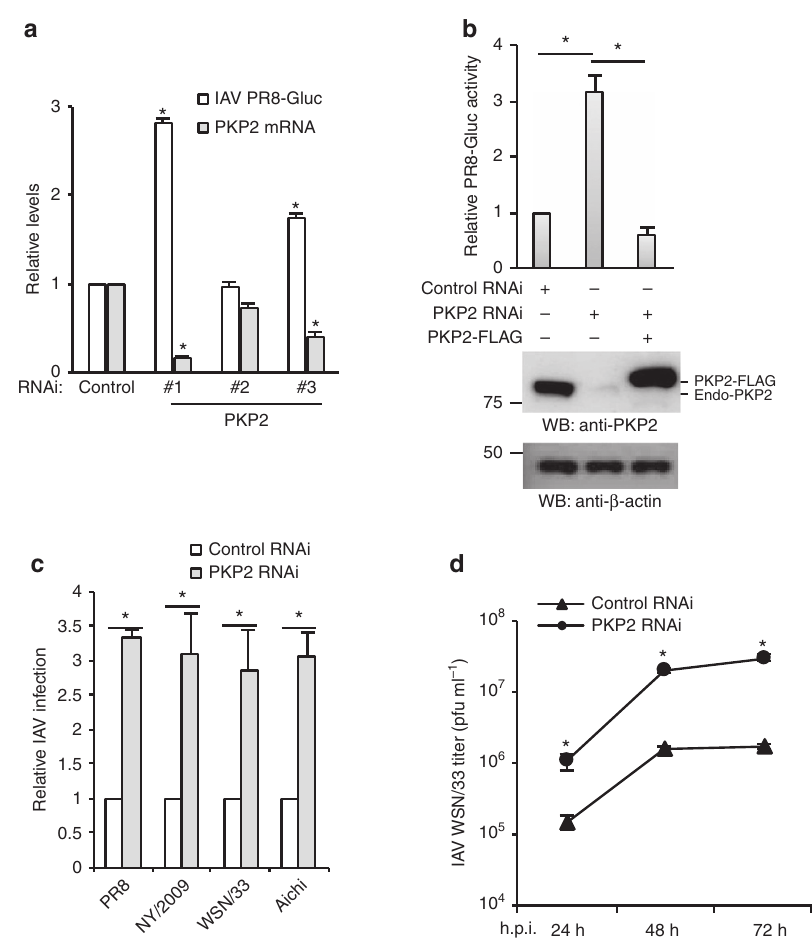
Figure 5 | RNAi depletion of PKP2 promotes influenza virus infection. ( a ) A549 cells were transfected with scrambled control siRNA and 3 siRNA oligos against PKP2. After 48h, the cells were infected with 0.1 MOI of IAV PR8-Gluc for 16h. Relative luciferase activities were examined and PKP2 mRNA levels were determined by RT-PCR. All experiments were biologically repeated three times. Data represent means ± s.d. of three independent experiments. The P value was calculated (two-tailed Student’s t -test) by comparison with the siRNA control in each cell group. An asterisk indicates P o 0.05. ( b ) HEK293 cells were transfected with siRNA targeting the 3’-UTR of PKP2 (duplex #1) and/or PKP2-FLAG resistant to PKP2 siRNA. After 48h, the cells were infected with 0.1 MOI of PR8-Gluc for 16h. The relative luciferase activity is shown. All experiments were biologically repeated three times. Data represent means ± s.d. of three independent experiments. The P value was calculated (two-tailed Student’s t -test) by comparison with the siRNA control. An asterisk indicates P o 0.05. Western blot demonstrates the knockdown efficiency. FLAG-tagged PKP2 and endogenous PKP2 (Endo-PKP2) are indicated. ( c ) A549 cells were transfected with PKP2 siRNA (duplex #1) for 48h, then infected with 1 MOI of PR8, WSN/33, NY/2009 or Aichi IAV. Fixed cells were stained with anti-NP antibody (PR8 and WSN/33), anti-HA (NY/2009) or anti-Aichi antibodies. The relative infection was determined from the ratio of positive cells. Data represent means ± s.d. of three independent experiments ( 4 80 cells counted per experiment). *P o 0.05 significantly different versus control RNAi as calculated by the two-tailed Student’s t -test. ( d ) Tracheal epithelial cells transfected with control or PKP2 siRNA were infected with 0.001 MOI of WSN/33 IAV for the indicated h.p.i. Titers of culture supernatants containing IAV were determined on MDCK cells, and plaques were enumerated. Data represent means ± s.d. of three independent experiments. The P value was calculated (two-tailed Student’s t -test) by comparison with the control RNAi. An asterisk indicates P o